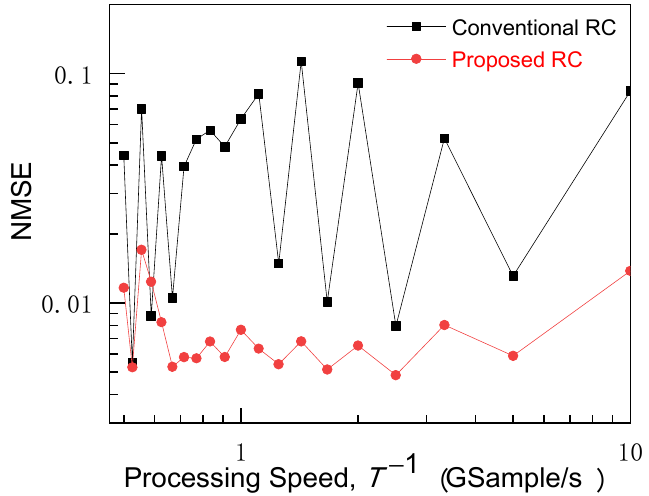
Figure 6. Measured NMSE as a function of processing speed T − 1 for conventional (black) and proposed (red) RCs.